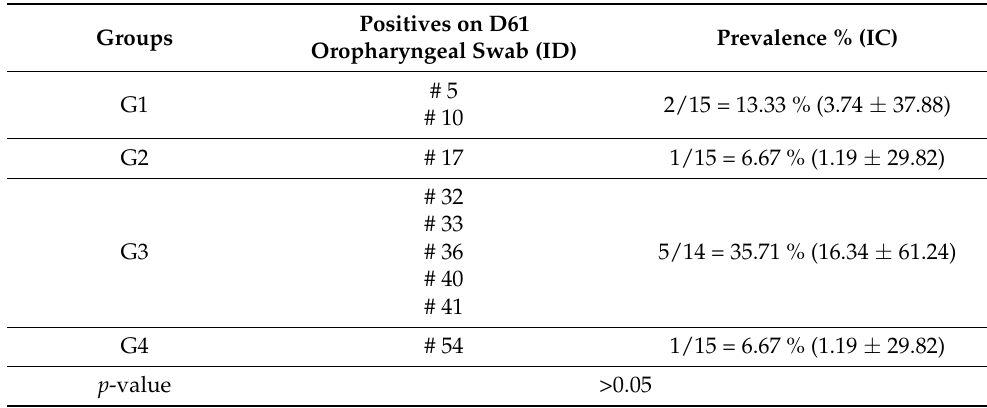
Table 3. Identification of animals positive for p102 gene detection in the oropharyngeal swab by qPCR followed by the prevalence and confidence interval of each group (G1 to G4) at